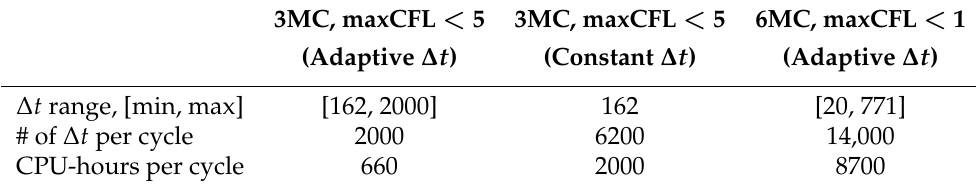
Table 1. Temporal statistics of the different time-stepping approaches, including the range of the time- step sizes ( ∆ t , in microseconds µ s ), number (#) of time-steps and computational costs (in CPU-hours) per